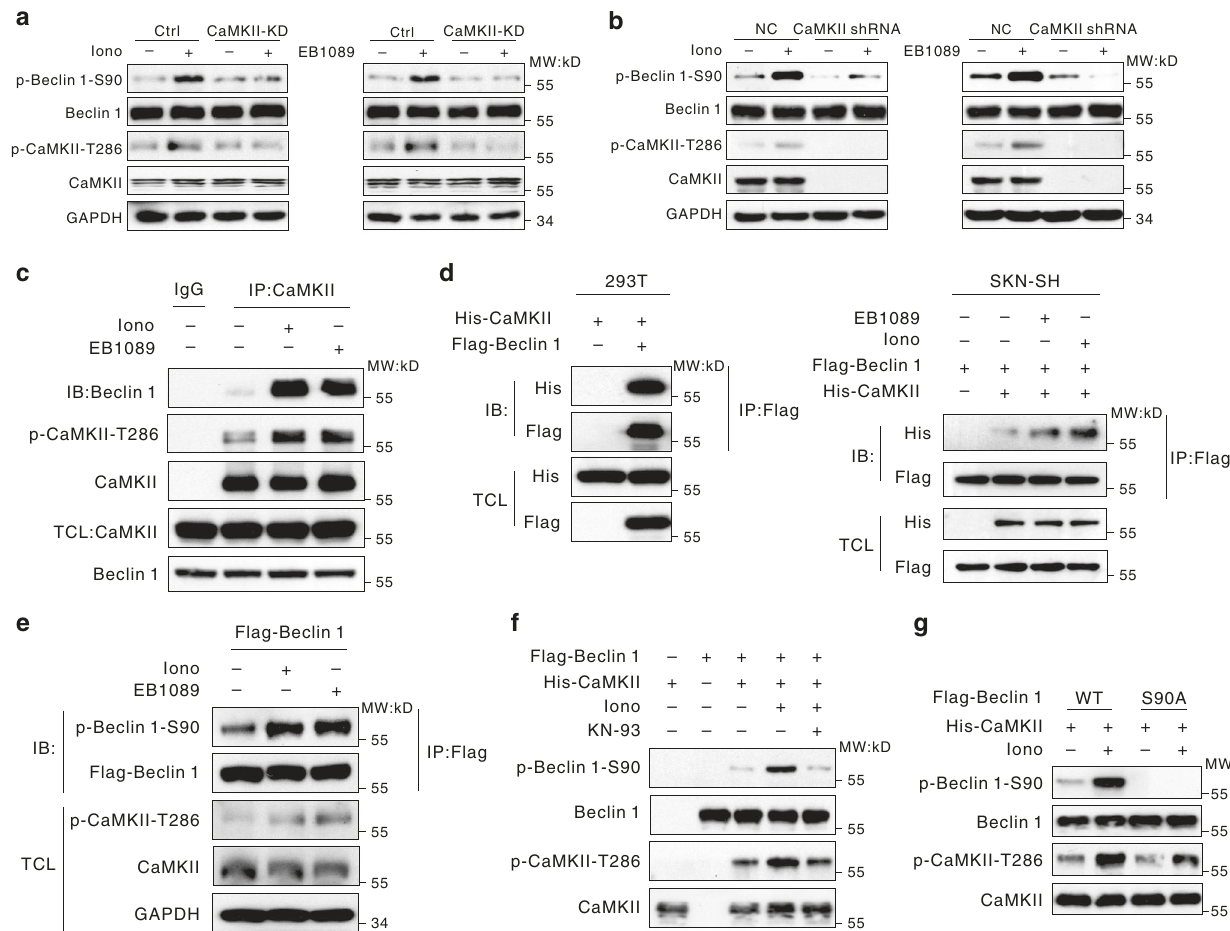
Fig. 2 CaMKII directly phosphorylates Beclin 1 at Ser90. a The phosphorylation of Beclin 1-S90 requires activated CaMKII. SK-N-SH cells were transiently transfected with a control vector or plasmids encoding His-CaMKII-KD for 48 h. The whole-cell extracts were subjected to western blotting using the indicated antibodies. b CaMKII is required for phosphorylation of Beclin 1 on S90. HEK293T cells were transiently transfected with negative control or CaMKII shRNA, and then untreated or treated with 6 μ M ionomycin or 100 nM EB1089 for 72 h. The cells were lysed and the indicated proteins were analyzed by western blot. c Increased association between CaMKII and Beclin 1 in cells treated with ionomycin or EB1089. HEK293T cells were treated with 6 μ M ionomycin or 100 nM EB1089 for 24 h, lysed, and then incubated with anti-CaMKII or control IgG antibodies prior to western blotting. The